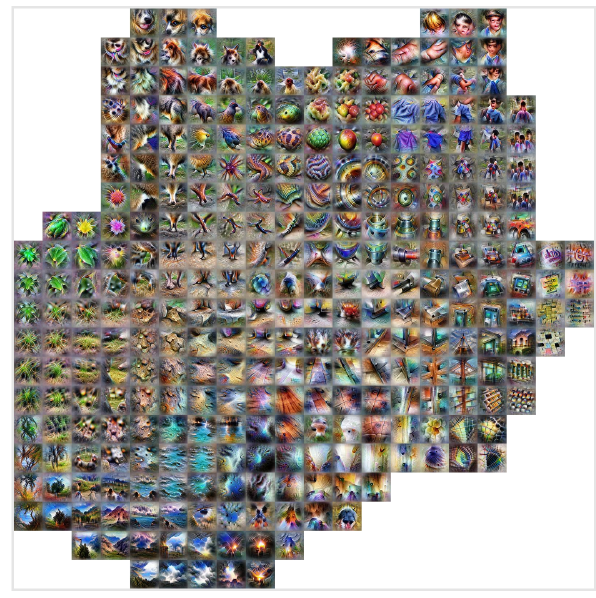
Figure 15. Activation atlases with 100,000 activations [63].